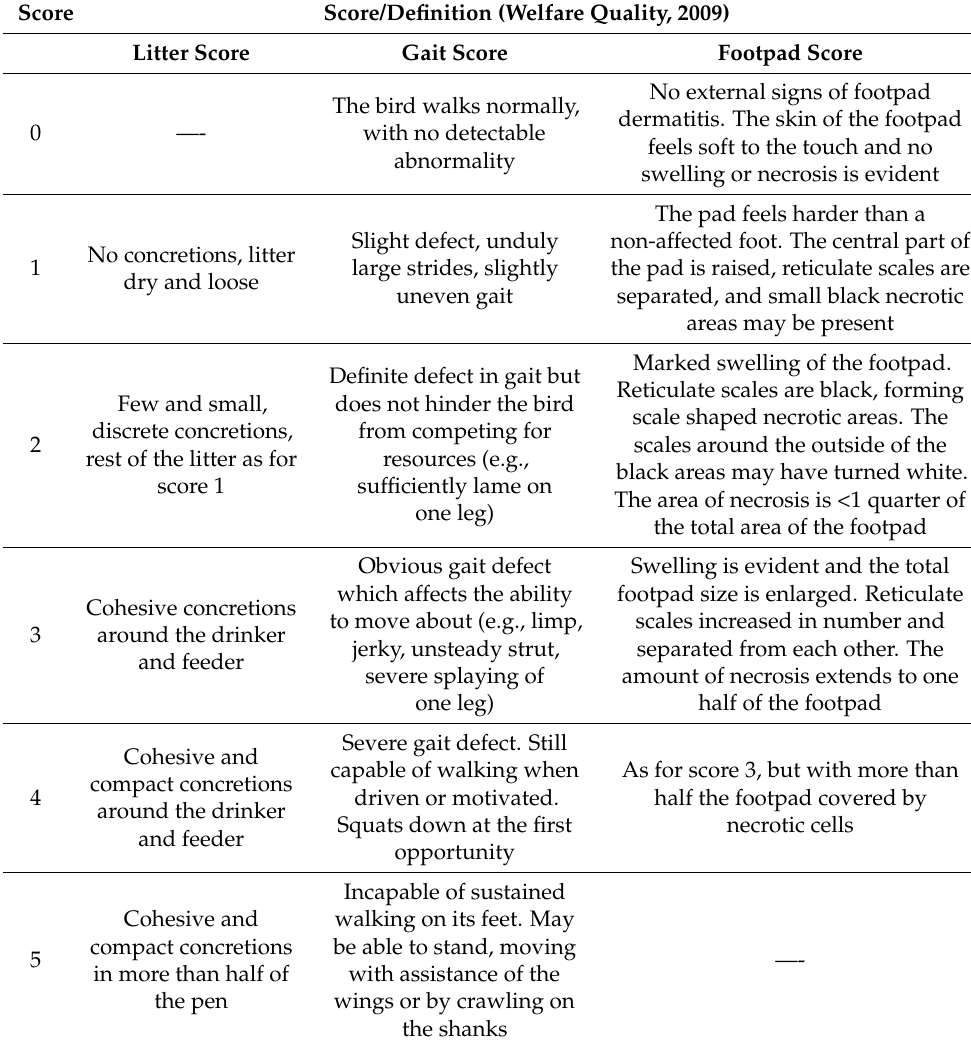
Table 2. Description of qualitative scoring system used in Trial 1 (litter score, gait score, and footpad score) and Trial 2 (footpad